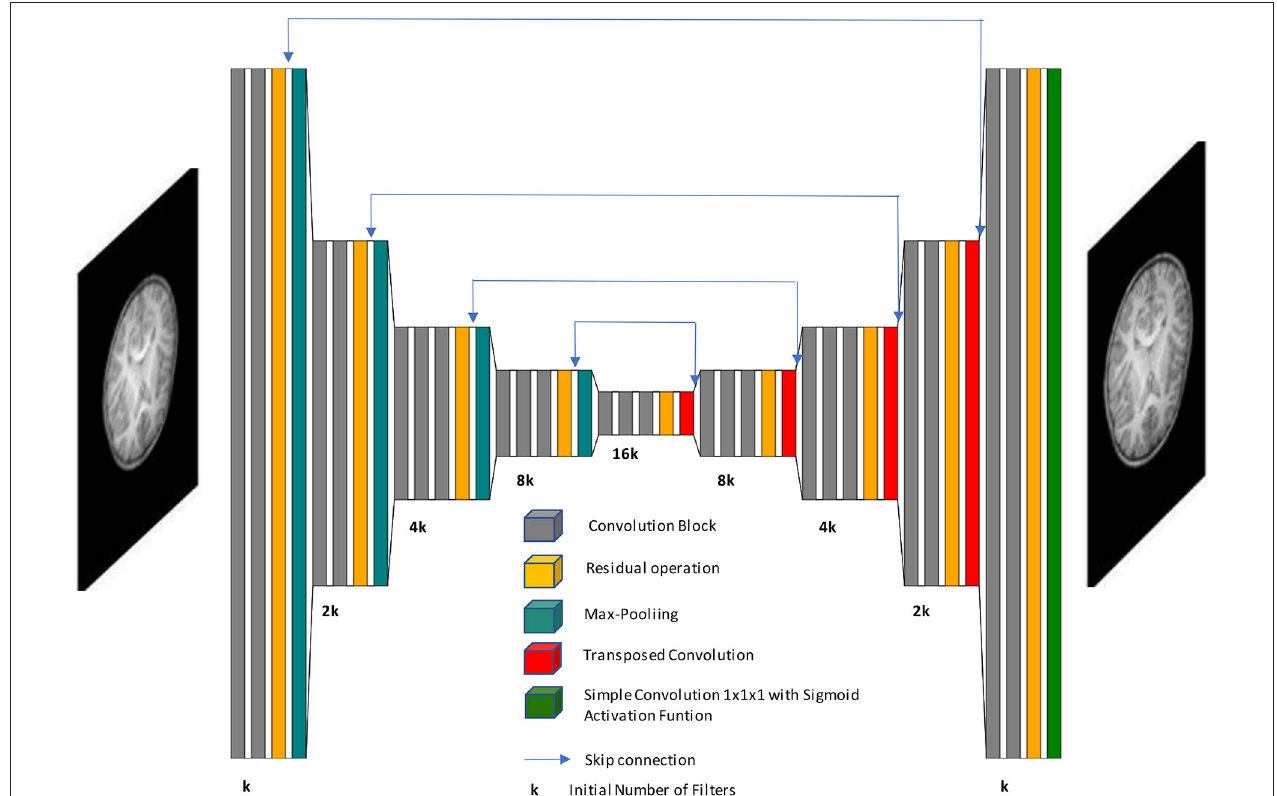
FIGURE 1 | Schematic representation of our network architecture. Our autoencoder implementation processes low-resolution images to generate high-resolution images.